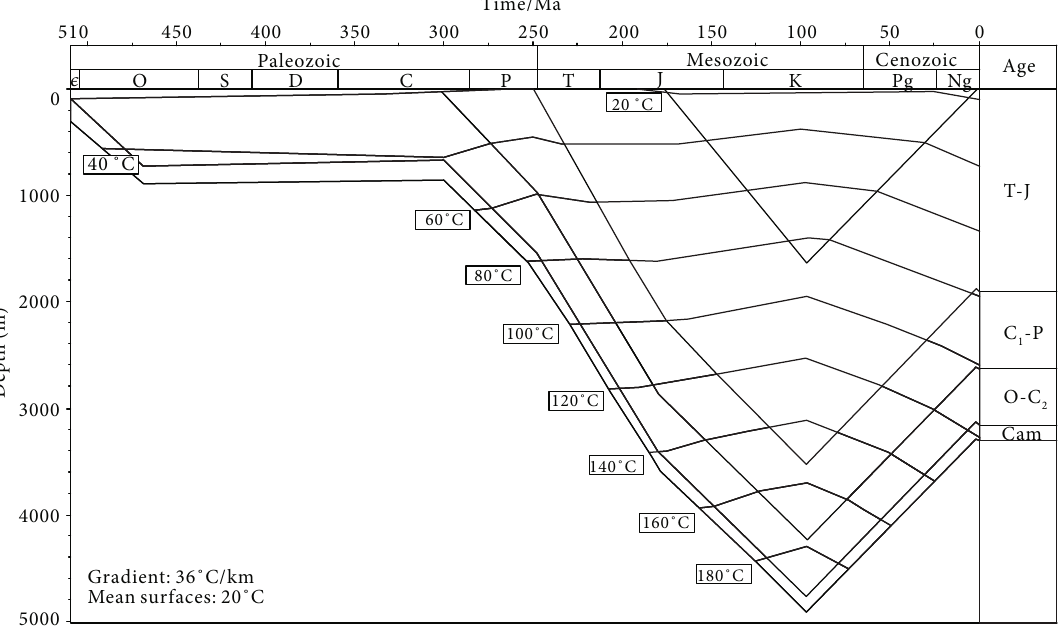
Figure 8: The burial history diagram of Yican 1 in the southeastern Ordos Basin (modi fi ed from